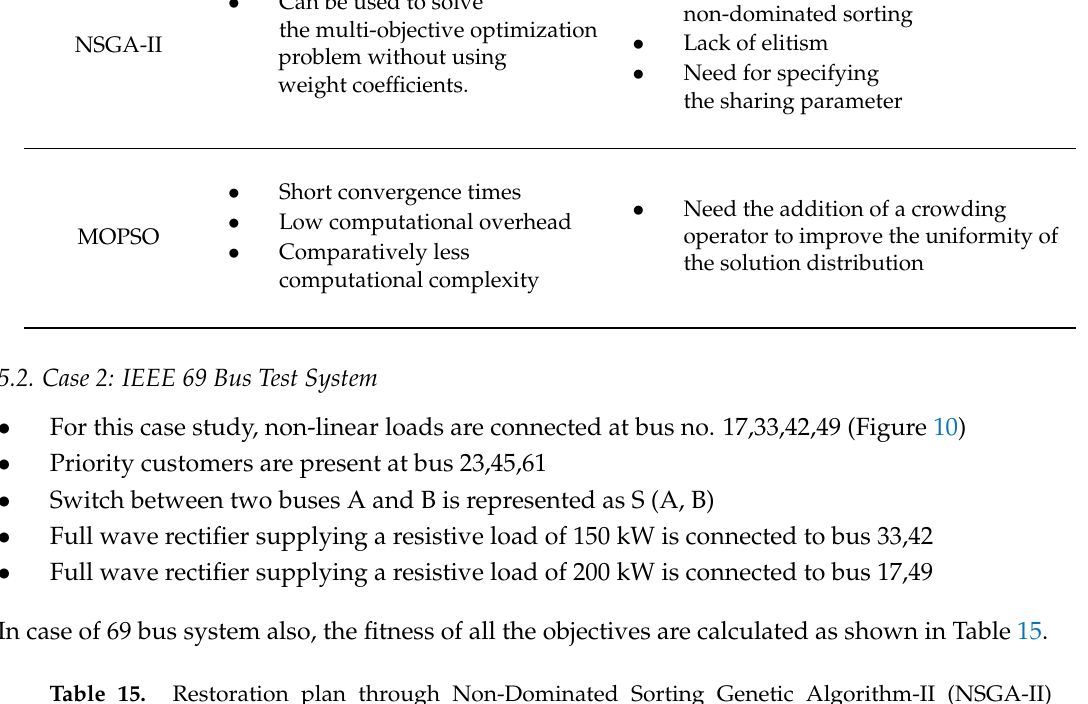
Restoration plan through Non-Dominated Sorting Genetic Algorithm-II (NSGA-II) and Multi-Objective Particle Swarm Optimization (MOPSO) algorithms when the fault occurred between bus 12 and bus